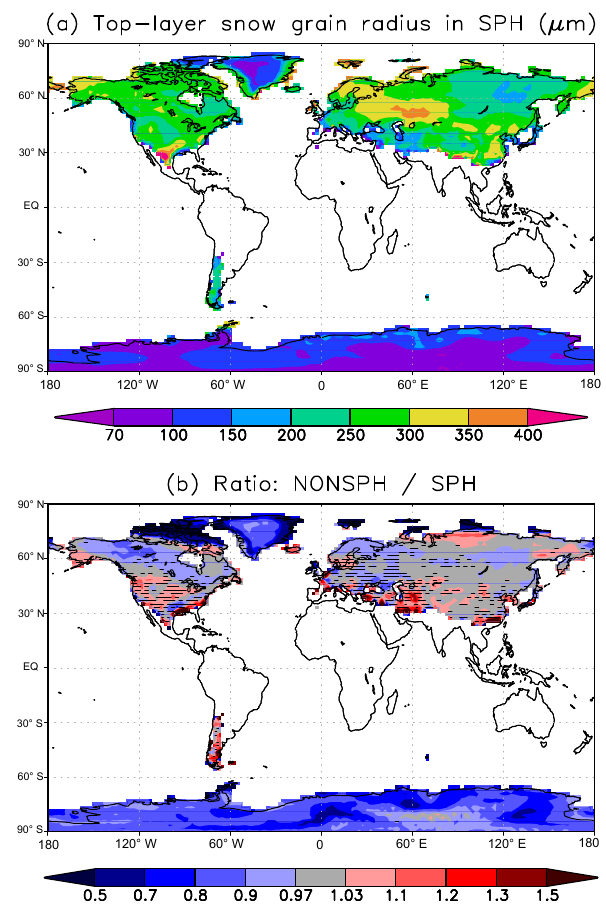
Figure 7. (a) Mean value of snow grain effective radius r e in the up- permost snow layer on land in the SPH experiment (µm; weighted by snow cover fraction) and (b) the ratio of r e in NONSPH to that in SPH. Hatching indicates ratios that exceed the threshold for colour shading (i.e. differ from 1 by more than 0.03) but are not significant at the 5%